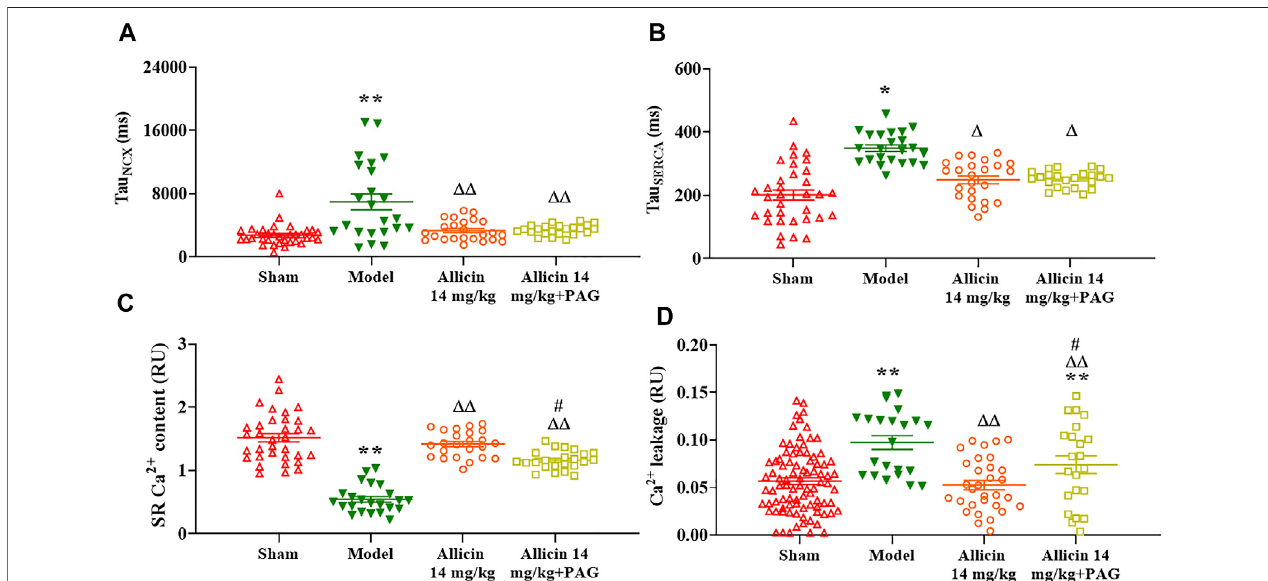
FIGURE 8 | Effect of allicin on myocardial Ca 2+ transport. (A,B) Allicin enhanced SERCA reabsorption and NCX-induced calcium ef fl ux in cardiomyocytes. (C,D) Allicin increased SR Ca 2+ content and reduced Ca 2+ leakage in cardiomyocytes. n (cid:1) 22 – 89 cardiomyocytes from 3 ‒ 5 rats. Data are presented as mean ± S.E.M. * p < 0.05,** p < 0.01vs.control; △ p < 0.05, △△ p < 0.01vs.theModelgroup; # p < 0.05vs.theAllicin14